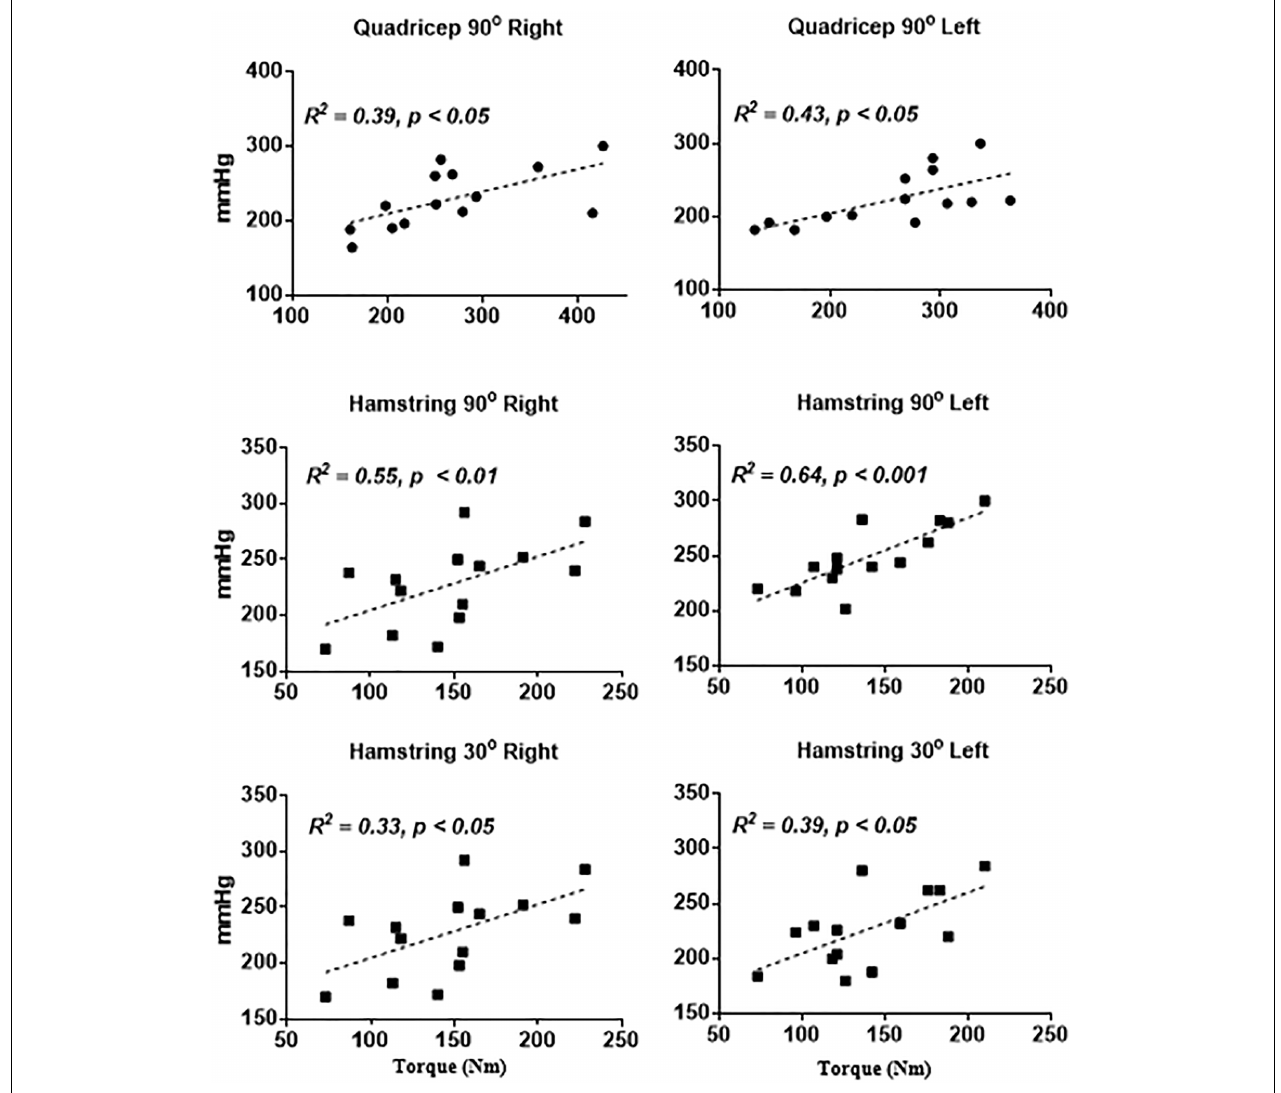
FIGURE 2 | Relationship between sphygmomanometer tests and isokinetic dynamometry (x-axis). sphygmomanometer reading are shown on the x-axis and expressed in